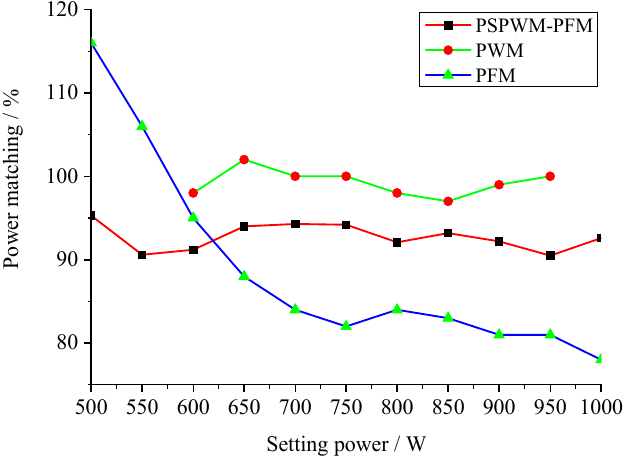
Figure 23. Power matching curve.